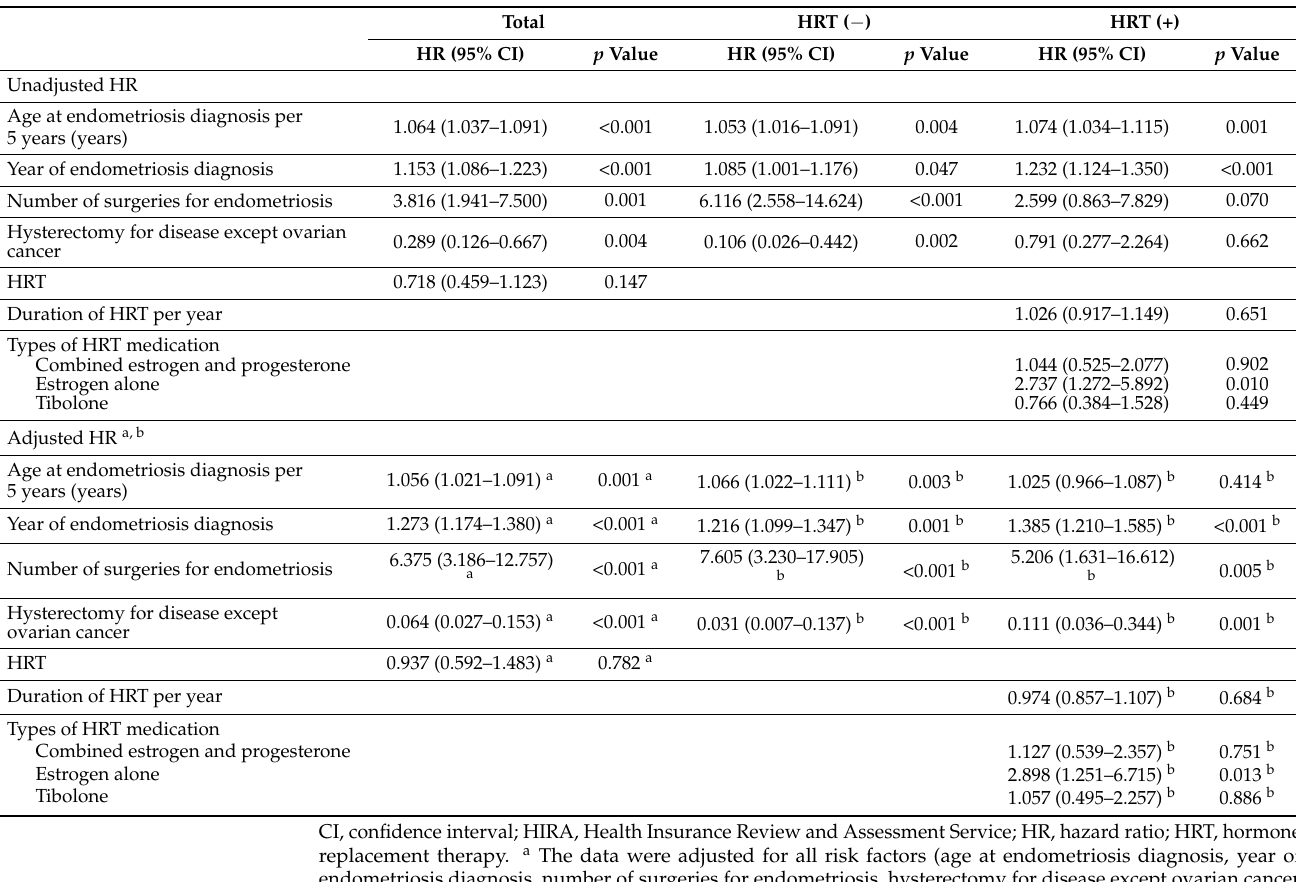
Table 3. Associations between risk factors and ovarian cancer occurrence according to HRT in women with endometriosis (HIRA claims data